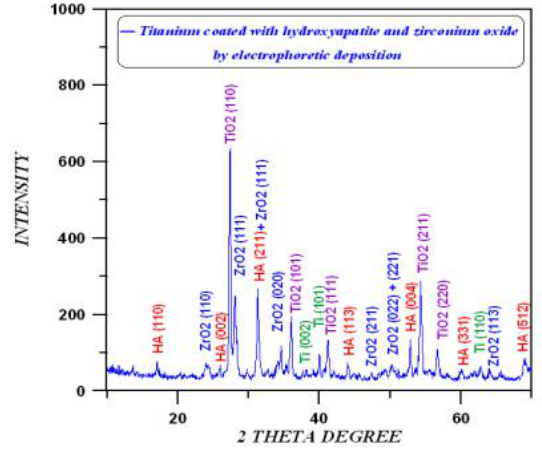
Figure 4: X-ray diffraction patterns of nano ZrO and nano Hapcoated cpTi specimen 2 Atomic force microscope of coating sample Coated specimen appear with small homogenous embedded nodules with average roughness 1.95 nm which are important for the osseointegration as illustrated in figure 5. (14)